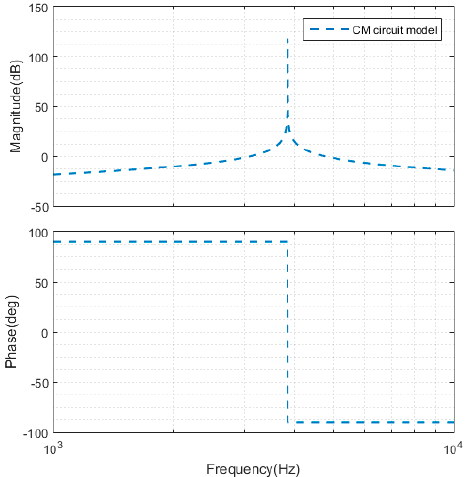
Figure 3. Bode diagram of CM LC circuit.